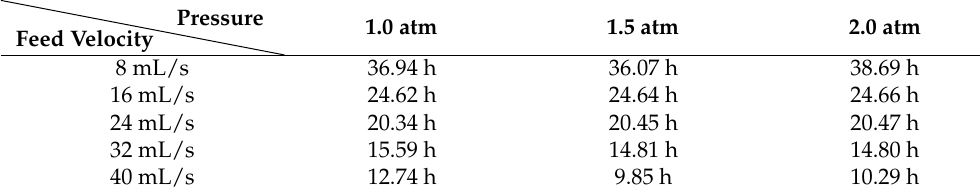
Table 1. Equilibrium time under different conditions in simulation. Feed Velocity